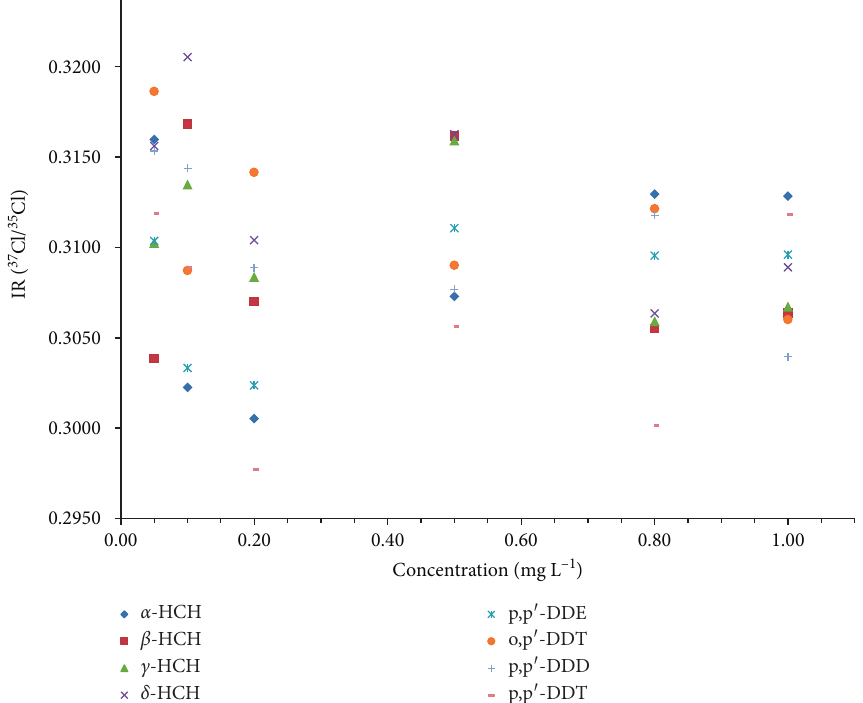
Figure 7: IR ( 37 Cl/ 35 Cl) values at different concentrations for eight organochlorine pesticides: α -hexachlorocyclohexane ( α -HCH), β -hexachlorocyclohexane ( β -HCH), c -hexachlorocyclohexane ( c -HCH), δ -hexachlorocyclohexane ( δ -HCH), 1-chloro-2-[2, 2, 2-trichloro- 1-(4-chlorophenyl) ethyl] benzol (o, p ′ -DDT), 2, 2-bis ( p -chlorophenyl)-1, 1, 1-trichloroethane ( p , p ′ -DDT), 2, 2-dichloro-1, 1-bis (4- chlorophenyl) ethylene ( p , p ′ -DDE), and 1, 1-dichloro-2, 2-bis ( p -chlorophenyl) ethane ( p , p ′